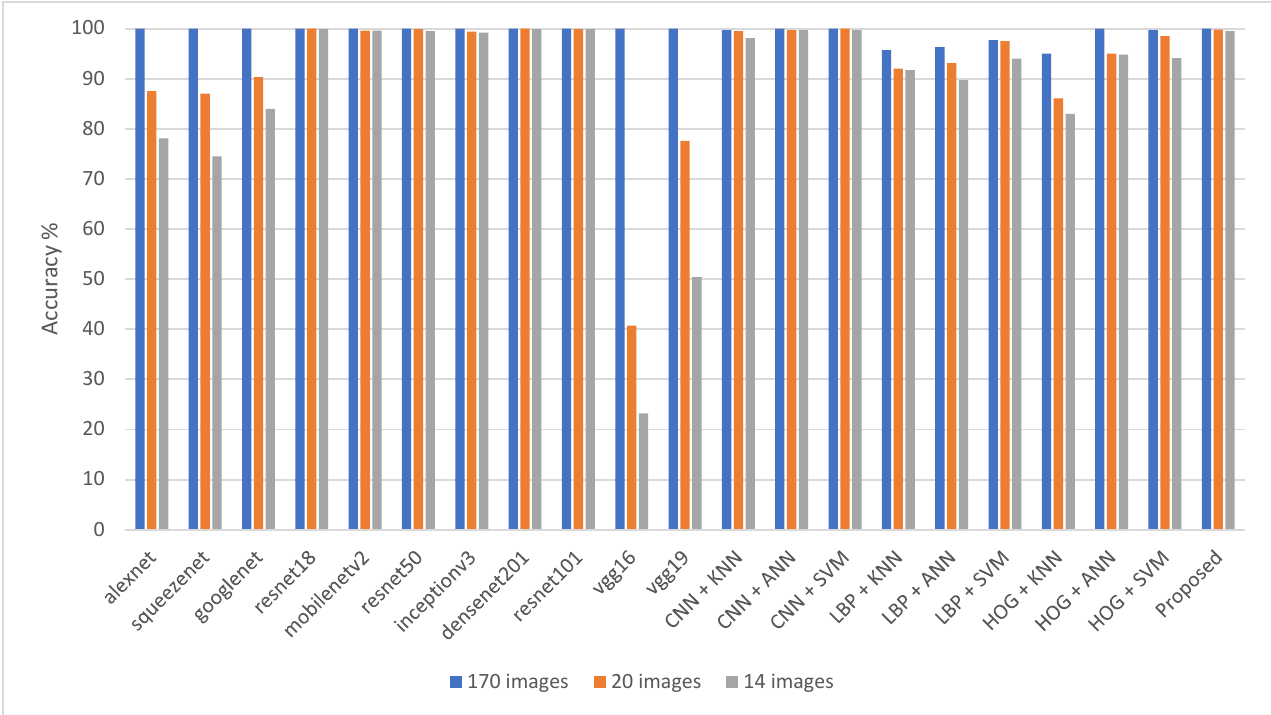
Figure 12. Confusion chart for proposed method (smallest training dataset).